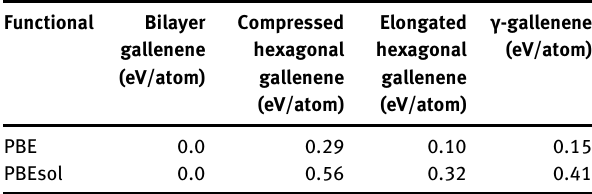
Table  : Relative energy of the different phases of gallenene measured as the total energy per atom as calculated in this work through PBE and PBEsol